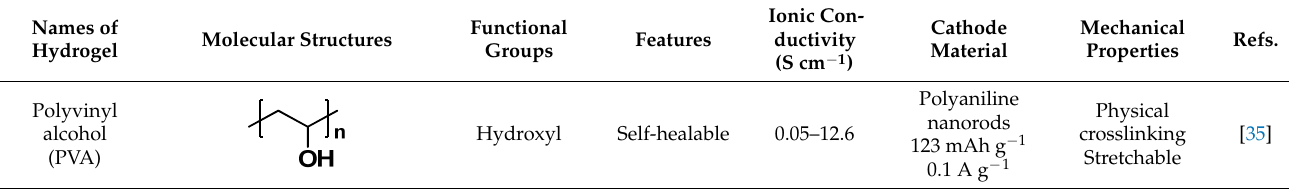
Table 1. Some representative polymer electrolytes for Zn-based batteries. Functional Groups